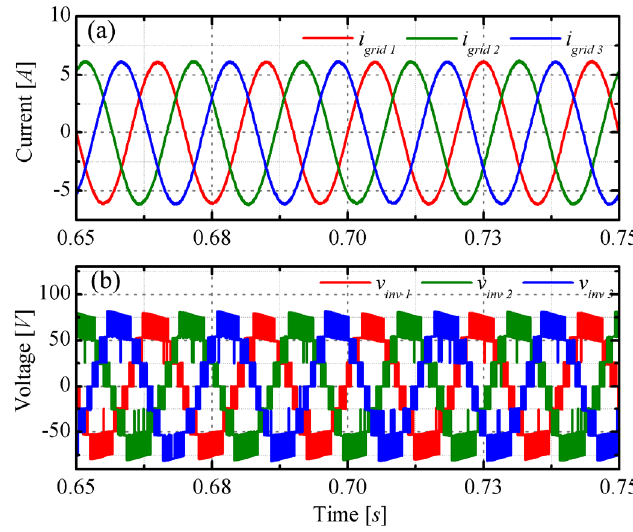
Figure 7. Sunny case: comparison among ( a ) phase currents i grid, p ; and ( b ) phase modulated voltages v inv,p .